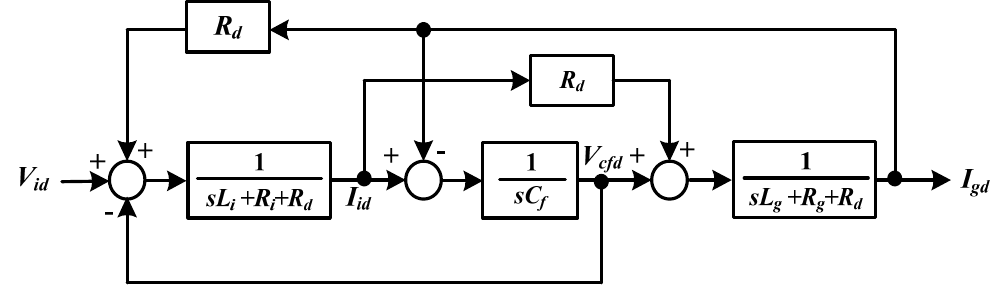
Figure 11. The LC filter in d-axis component